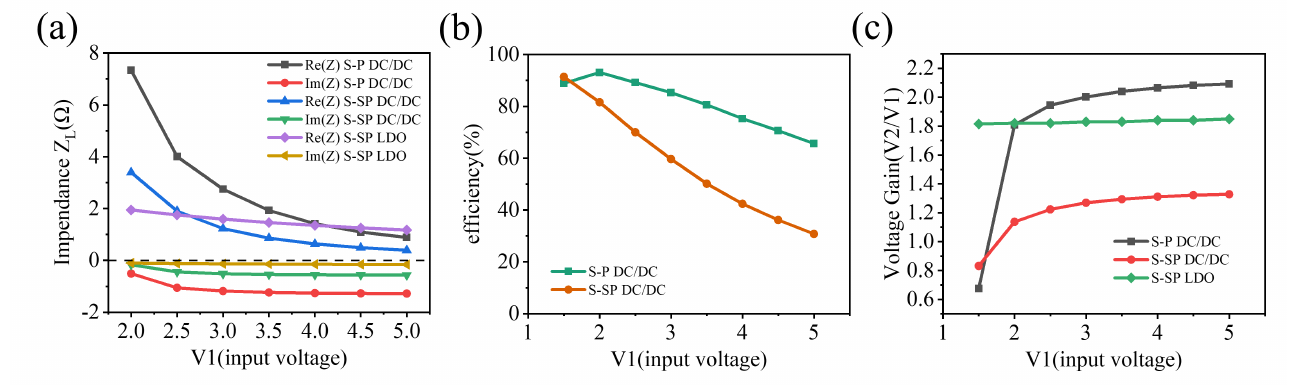
Figure 5. The simulated results of the WPT system. ( a ) The load equivalent impedance varies with the transmit voltage in S − P and S − SP typologies, ( b ) the variation of the WPT system efficiency with transmitting voltage, ( c ) the variation of voltage gain with transmitting